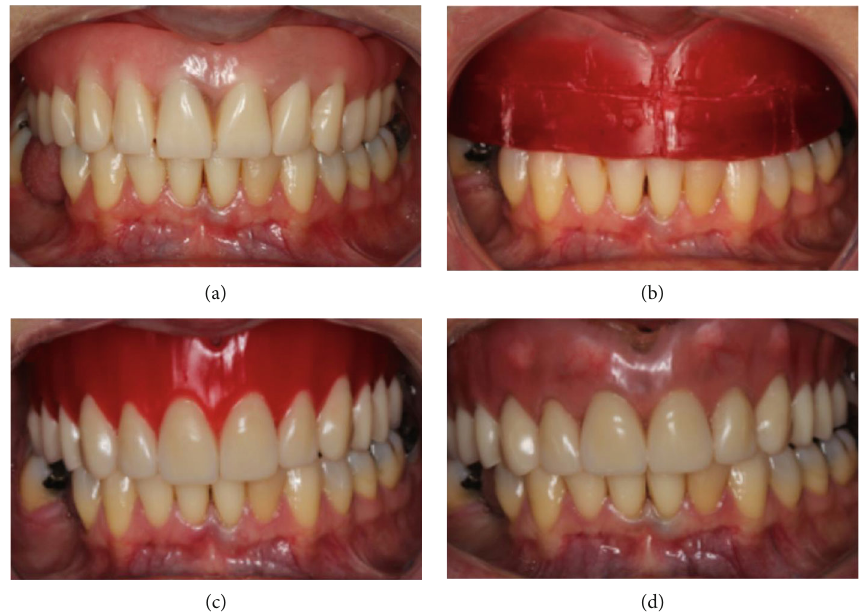
Figure 3: Prosthetic procedures were carried out to install a provisional prosthesis attached to two short implants by means of o-ring connection (a –